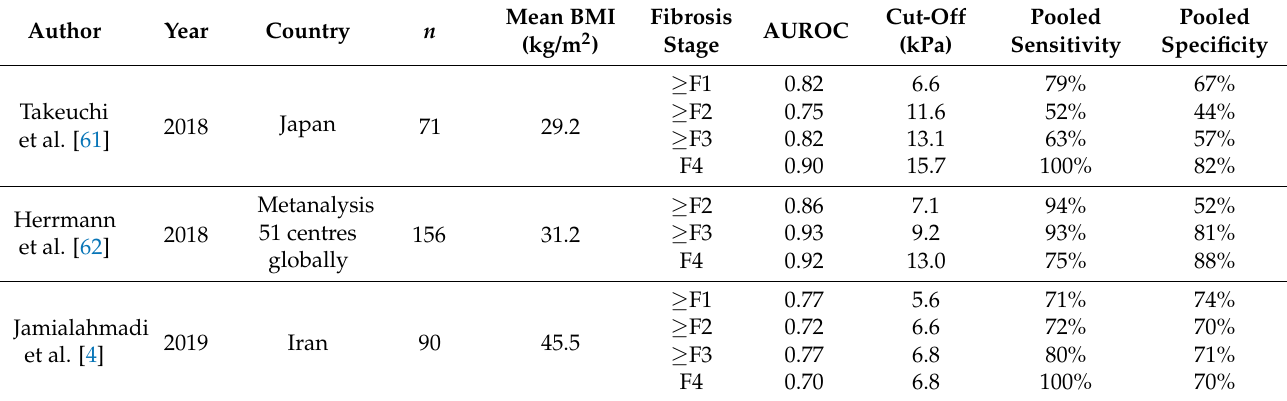
Table 1. Diagnostic performance of 2D-SWE for different fibrosis stages in patients with non-alcoholic fatty liver disease (NAFLD).